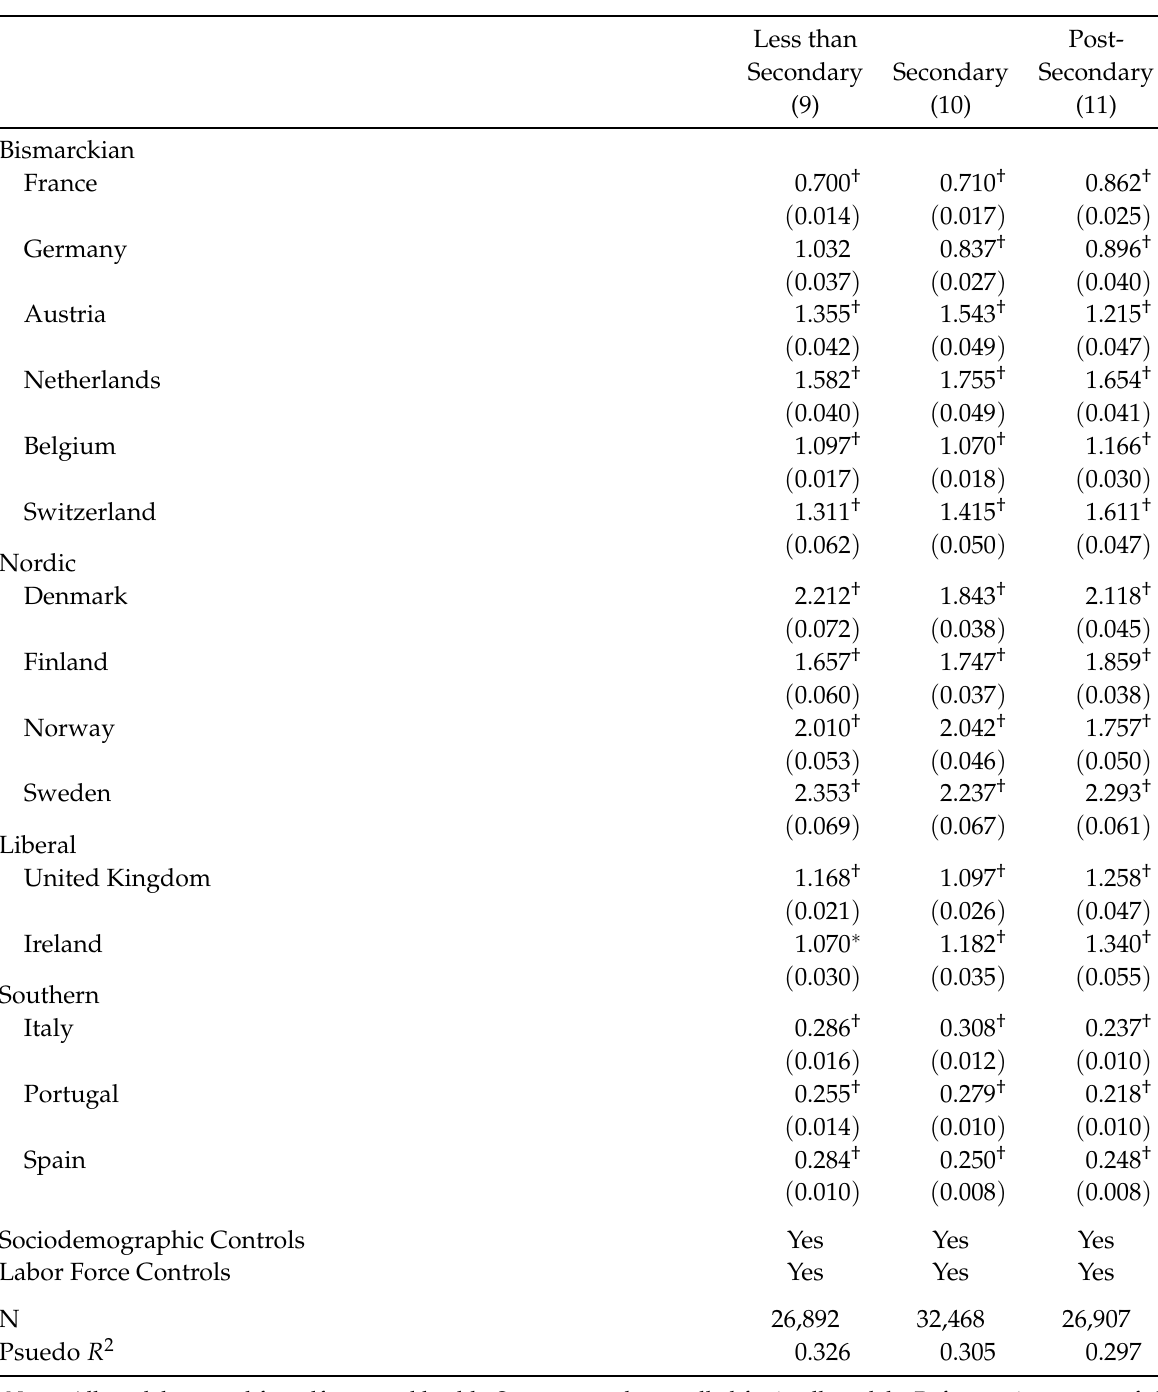
Table 4: Logistic Models Predicting Disability Status by Country of Residence and Level of